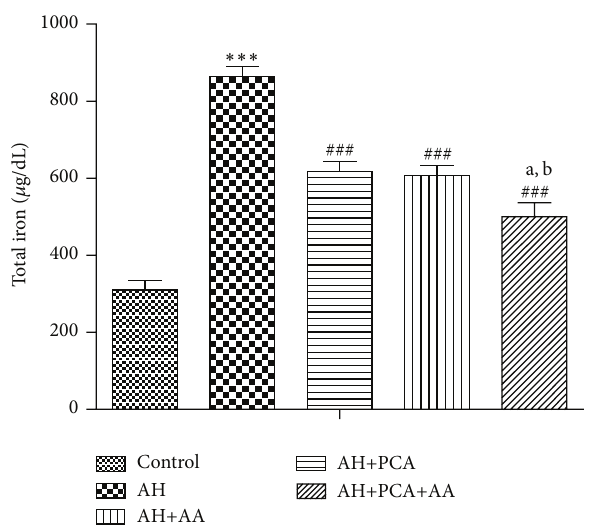
Figure 4: Effect of PCA alone and in combination with AA on total iron content in AH-treated rats. Values are expressed as mean ± SEM. Level of significance is considered as ∗ 𝑝 < 0.05 , ∗∗ 𝑝 < 0.01 , and ∗∗∗ 𝑝 < 0.001 compared to control group. # 𝑝 < 0.05 , ## 𝑝 < 0.01 , and ### 𝑝 < 0.001 compared to AH-treated group. a 𝑝 < 0.05 compared to AH+PCA and b 𝑝 < 0.05 compared to AH+AA group.